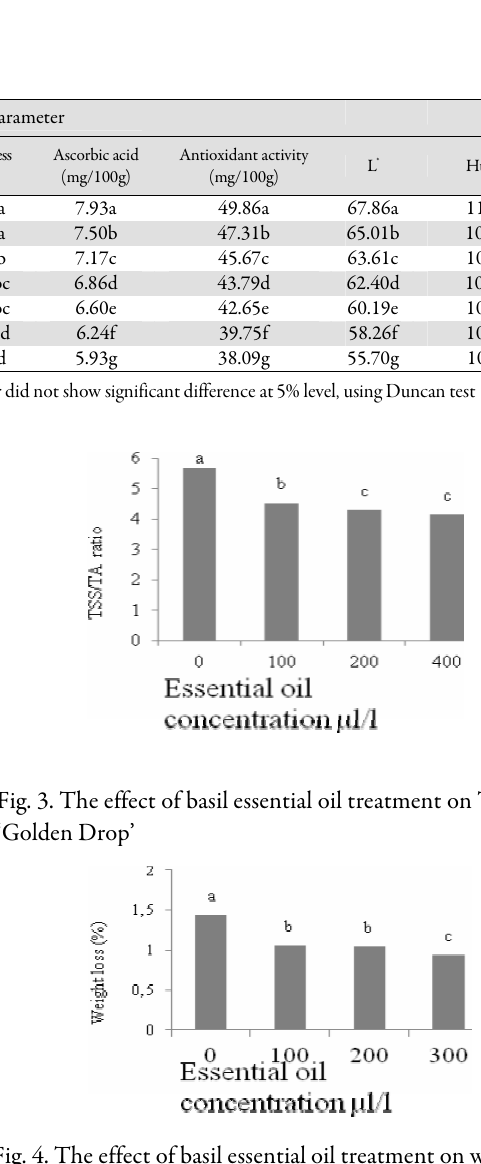
Fig. 4. The effect of basil essential oil treatment on weight loss of ‘Golden Drop’